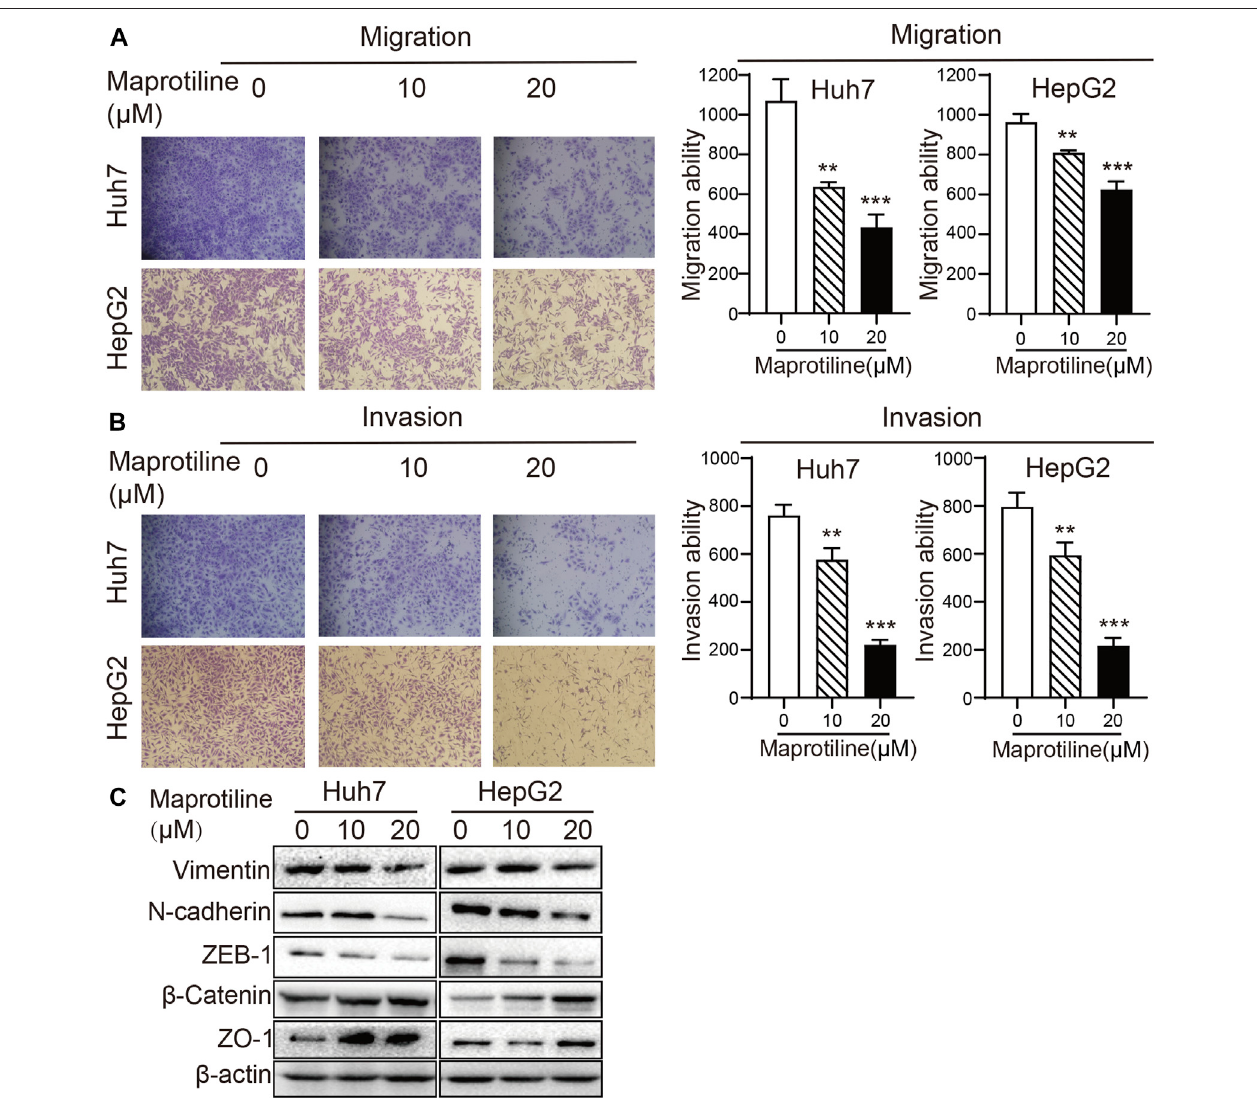
FIGURE 2 | Maprotiline suppresses the migration and invasion of Huh7 and HepG2 HCC cells. (A, B) The migration and invasion of Huh7 and HepG2 cells were substantially inhibited by treatment with maprotiline at concentrations of 10 and 20 μ M for 24 h, and wells without maprotiline were used as controls. (C) Huh7 and HepG2 cells were exposed to maprotiline at concentrations of 0, 10, and 20 μ M for 72 h. Expression of the EMT-related proteins ZO-1, β -catenin, ZEB-1, N-cadherin and Vimentin displayed a dose-dependent effect in Western blot results, and β -actin was used as an internal reference